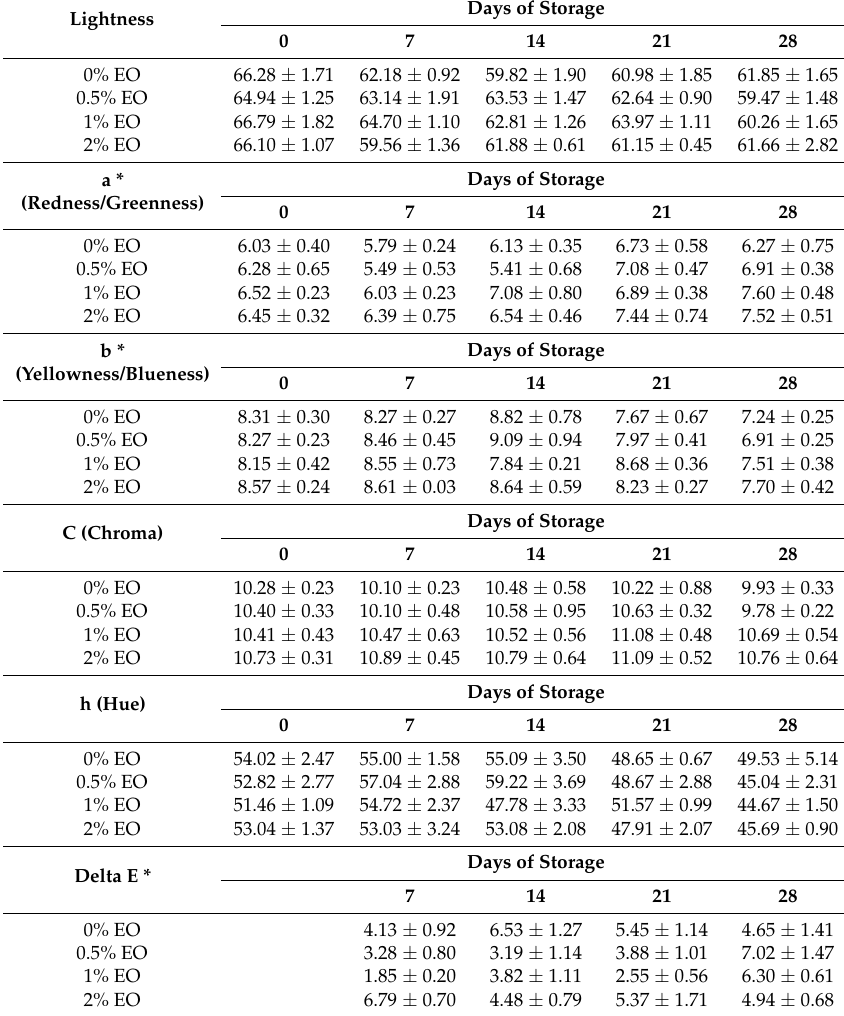
Table 4. Color parameters (mean ± standard deviation) in RTE meat packaged during refrigerated storage (0% EO: control films; 0.5% EO: films with 0.5% thyme essential oil; 1% EO: films with 1% thyme essential oil; 2% EO: films with 2% thyme essential oil). * Delta E, total color differences between 0% EO (day